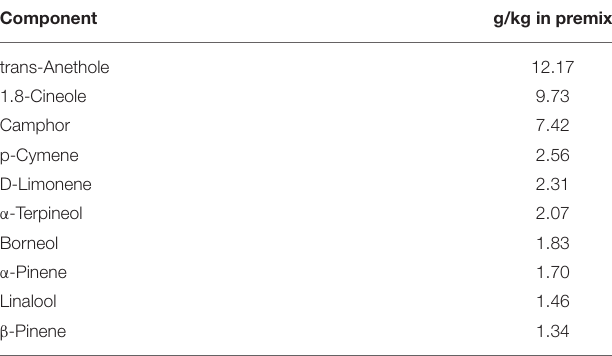
TABLE 1 | Composition of supplemented EO in the BPC a